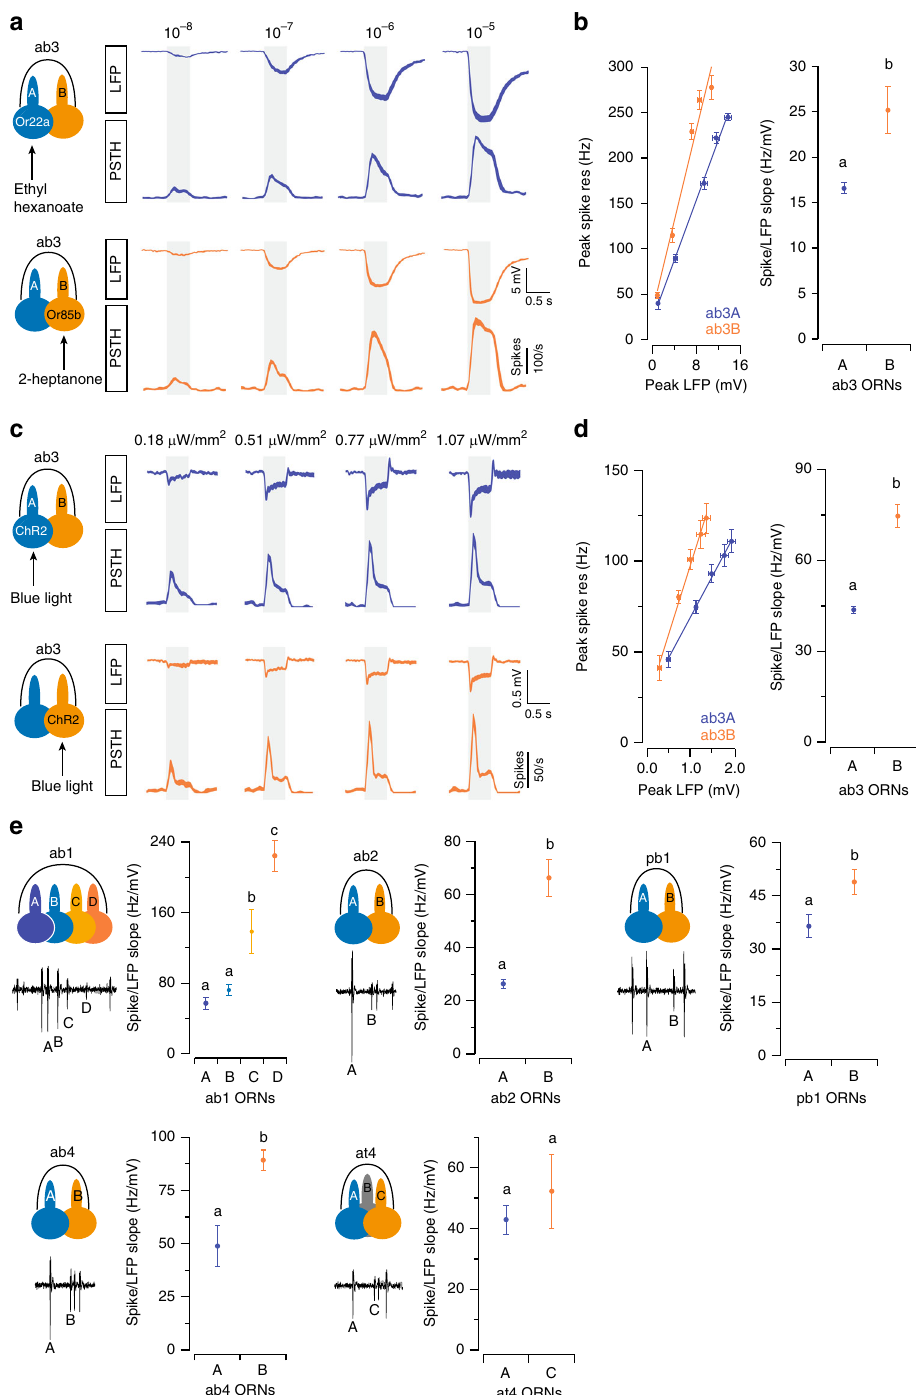
Fig. 3 Comparison of the spiking properties of grouped neurons. a ab3 ORNs were selectively activated by their respective private odorants. a Average LFP responses and the corresponding spike responses are shown for ab3A (blue) and ab3B (orange). b Peak spike responses are plotted as a function of peak LFP responses (left). The absolute values of the peak LFP responses were used for all analyses. Lines indicate linear fi ts ( y = ax + b ). n = 9 pairs of ORNs, mean ± s.e.m. The respective “ a ” coef fi cients (spike/LFP slope) are plotted for comparison (right). Error bars = s.d. c , d Similar to ( a , b ) except that ab3A and ab3B were activated optogenetically. H134R-Channelrhodopsin2 (ChR2) was expressed in either ab3A or ab3B by the GAL4-UAS system. ORNs were activated by 500-ms pulses of blue light (470 nm, irradiances are indicated above). n = 9, parallel experiments. e Optogenetic analyses in fi ve additional sensilla. ORNs expressing H134R-ChR2 were activated by blue light and the peak spike and LFP responses were analyzed as shown in ( d ). Error bars = s.d. n = 9, parallel experiments. Statistical analysis was performed with ANCOVA and signi fi cant differences ( P < 0.05) are denoted by different letters. The P values are b 0.012; d 0.0001; e ab1A-B: 0.529, ab1A-C: 0.044, ab1A-D: 0.001, ab1B-C: 0.041, ab1B-D: 0.004, ab1C-D: 0.042, ab2A-B: 0.001, pb1A-B: 0.041, ab4A-B: 0.018, at4A-C: 0.566. Source data are provided as a Source Data fi le. LFP local fi eld potential, ORN olfactory receptor neuron,